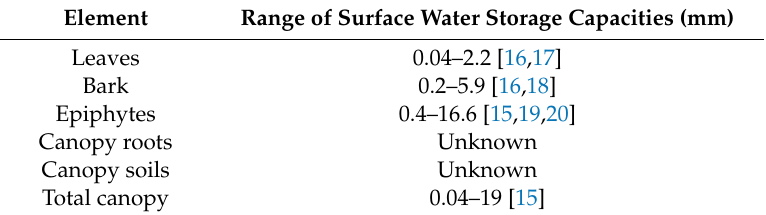
Table 1. Range of plot-scale surface water storage capacity observations for each major canopy element. Global range of total canopy surface water storage capacity is estimated via